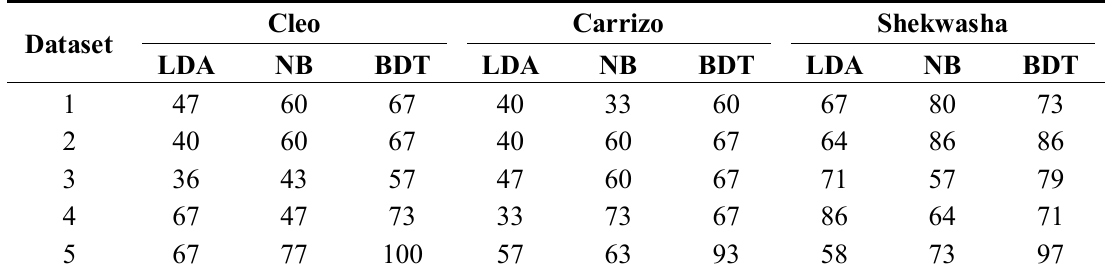
Table 2. Overall accuracy (%) of classification algorithms on data collected through visible-near infrared (VNIR)